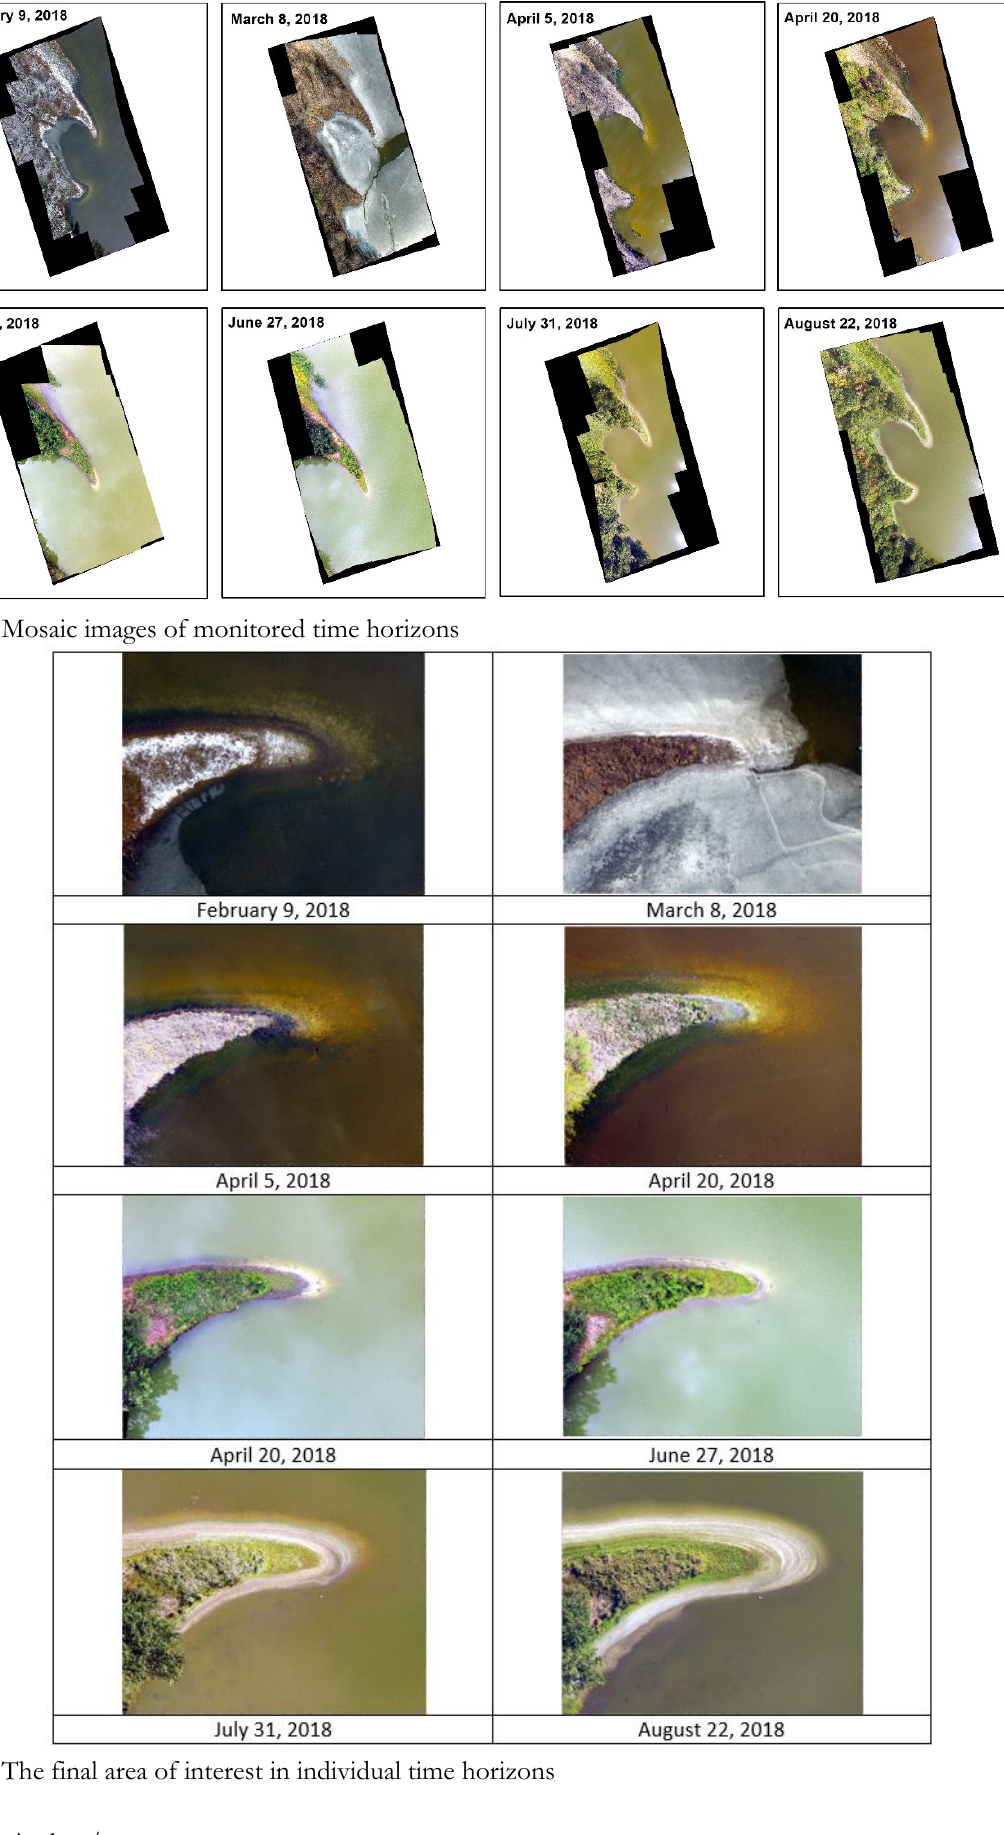
Figure 5. The final area of interest in individual time